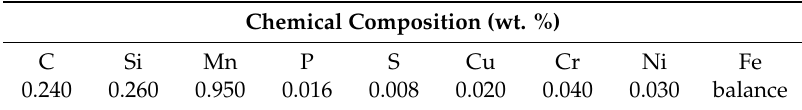
Table 1. Chemical composition of steel (wt. %).